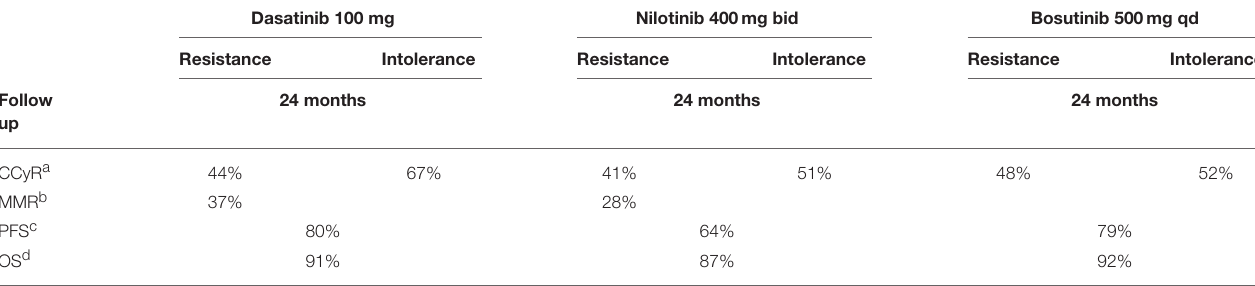
TABLE 2 | Treatment responses with 2GTKI in patients with imatinib